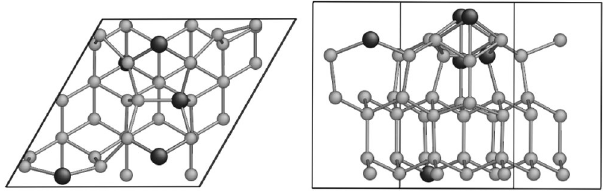
FIG. 14. Two views of the DAS 3 × 3 (111) surface reconstruction configuration that is in the database with atoms, marked with dark gray, whose environments are selected to be among the representative set for the purposes of defining the GAP